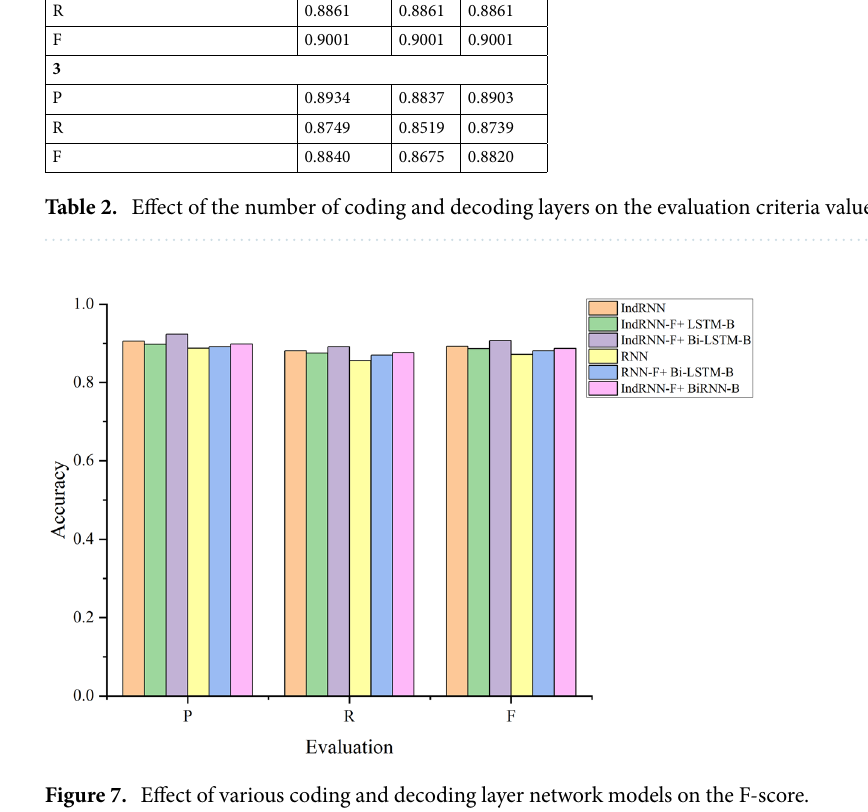
Figure 7. Effect of various coding and decoding layer network models on the